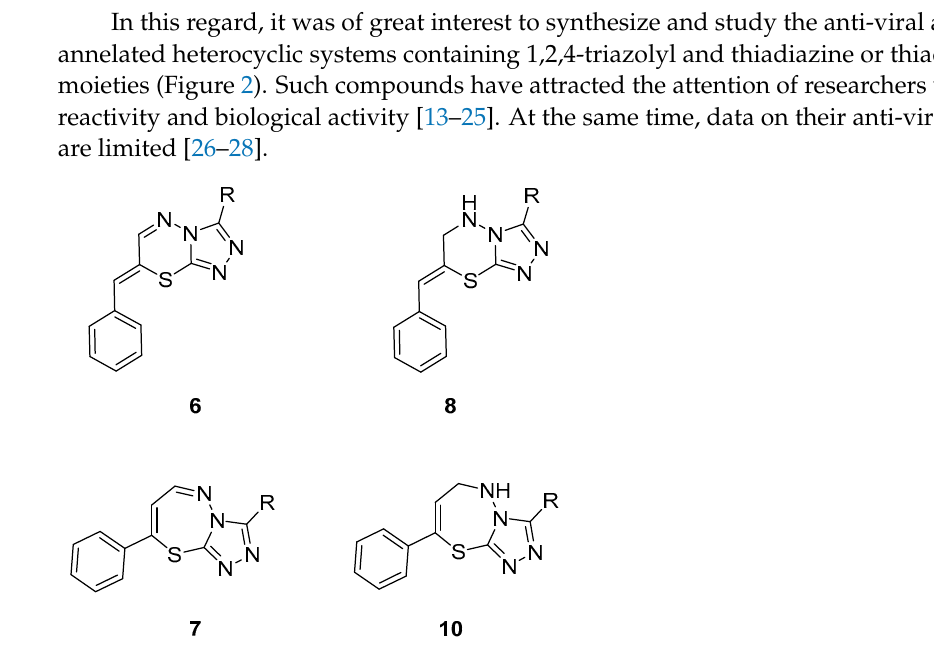
Figure 1. Active pharmaceutical ingredients of drugs used in influenza chemotherapy.